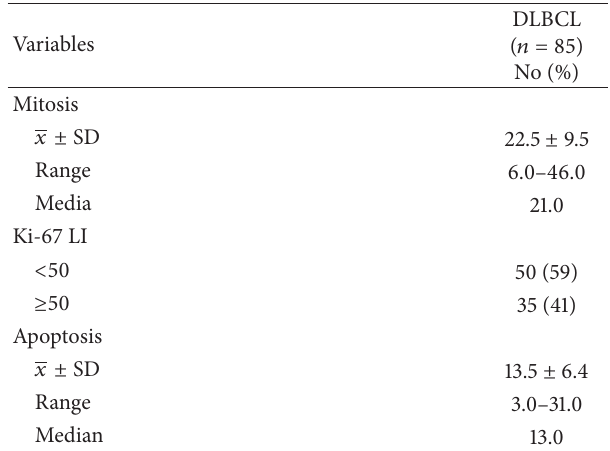
Table 1: Clinicopathological characteristics of DLBCL cases stud-